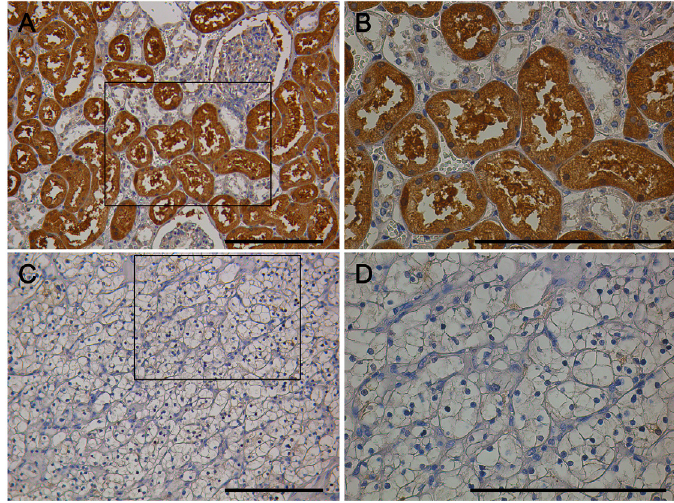
Figure 1. IHC (Immunohistochemistry) of nonEN2 expression using ab28731 in CCRCC (Clear Cell Renal Cell Carcinoma). ( A and B ) Kidney normal tissue, boxed areas in the 200× graphs are shown in the corresponding 400× graphs; ( C and D ) Kidney tumor tissue, boxed areas in the 200× graphs are shown in the corresponding 400× graphs. Insert bar = 100 μ m.